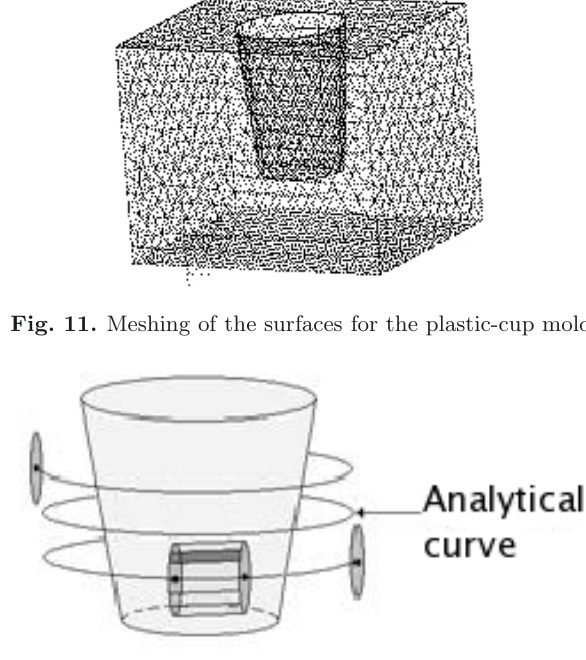
Fig. 12. Discretization into straight cylinder